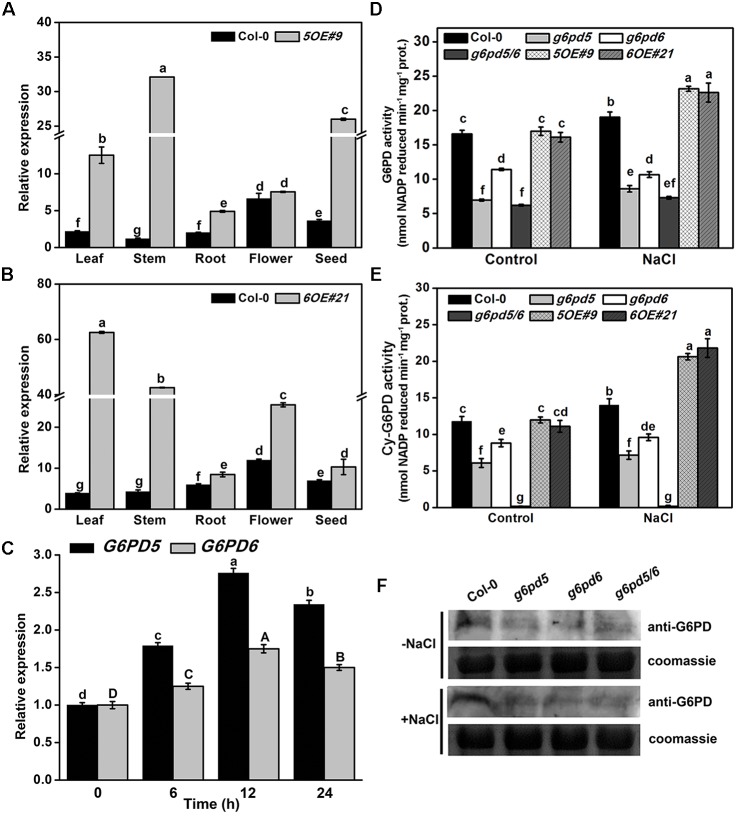
The analysis of cy-G6PD in Arabidopsis seedlings with or without salt treatment. (A,B) The qRT-PCR analysis of G6PD5 (WT and 5OE#9) and G6PD6 (WT and 6OE#21) expression in Arabidopsis different organs. (C) Relative transcript levels of G6PD5 and G6PD6 in wild-type (Col-0) seedlings with the 150 mM NaCl treatment. Uppercase letters represent the error analysis of G6PD6, and lowercase letters represent the error analysis of G6PD5. (D,E) The activities of G6PD or cy-G6PD in Arabidopsis WT and mutants exposed to salt treatment. (F) Western blot analysis of G6PD expression in Arabidopsis. In this experiment, 150 mM NaCl was used for treatment. The Coomassie Brilliant Blue-stained gel was present to show that an equal amount of proteins was loaded in all lanes. Data are mean ± SE of three independent experiments, bars with different letters are significantly different at the level of P < 0.05. The experiment was repeated three with similar results.